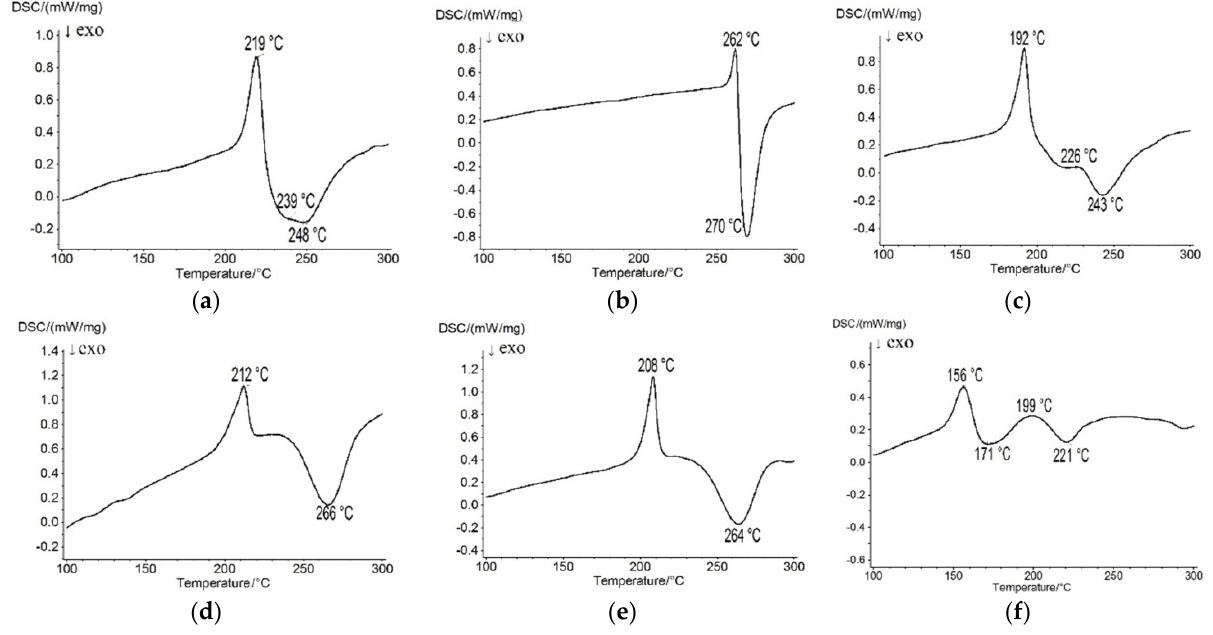
Figure 4. DSC curves of Chr-An1 ( a ), Chr-An2 ( b ), Chr-An3 ( c ), Chr-Car ( d ), Chr-PT ( e ) and Chr-TQ ( f ).